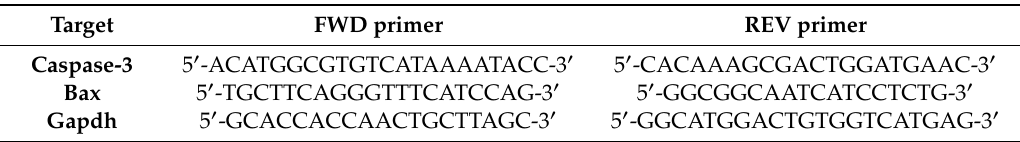
Table 3. Primers and their sequences used for RT-qPCR